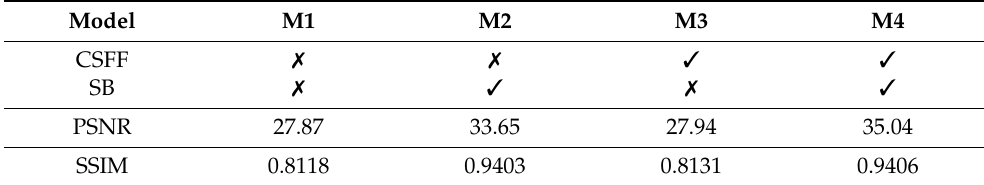
Table 3. Average ablation results for various combinations of the proposed sub-models when applied to various synthetic datasets.